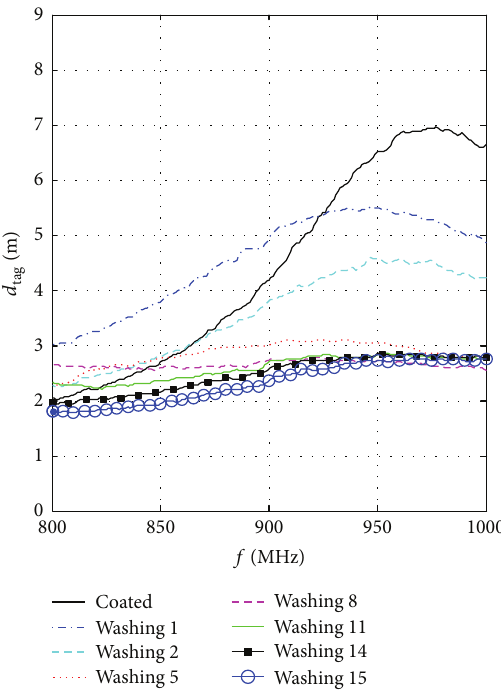
Figure 7: Measurement results for a tag where the read range was steadily decreasing after each washing cycle.